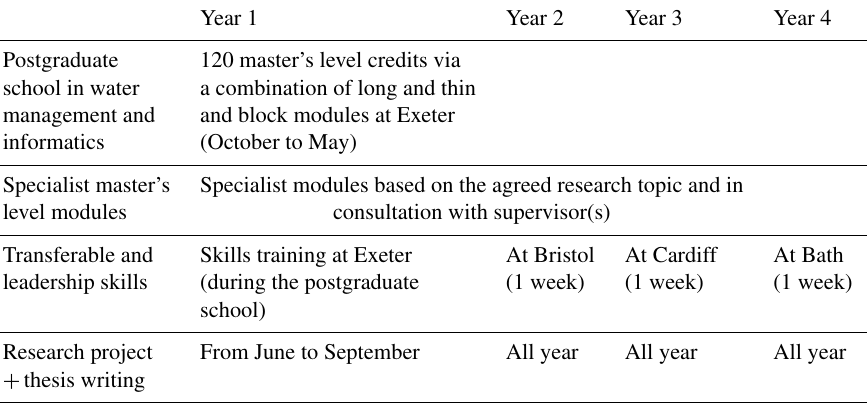
Table 1. WISE CDT programme